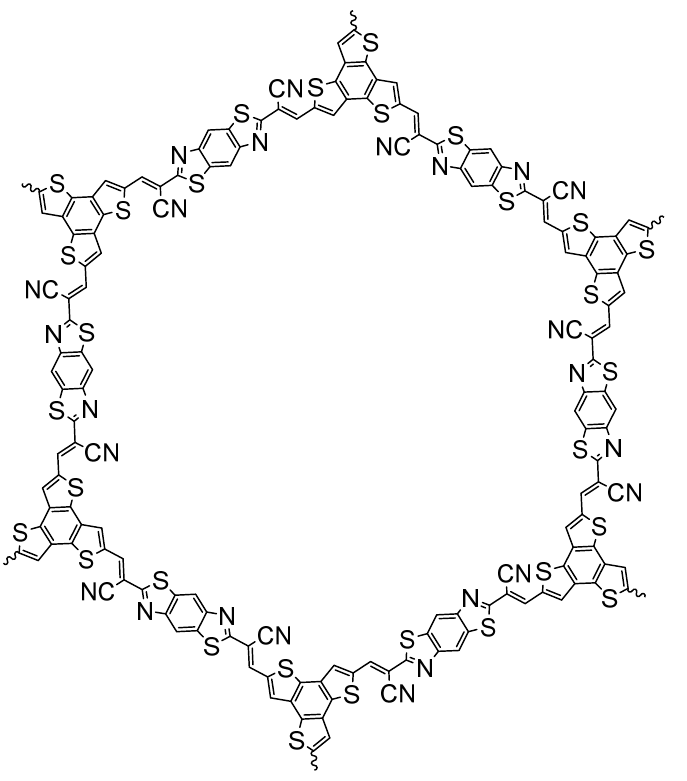
Figure 32. An example of a vinylene-linked COF for photocatalytic hydrogen production from water [149].